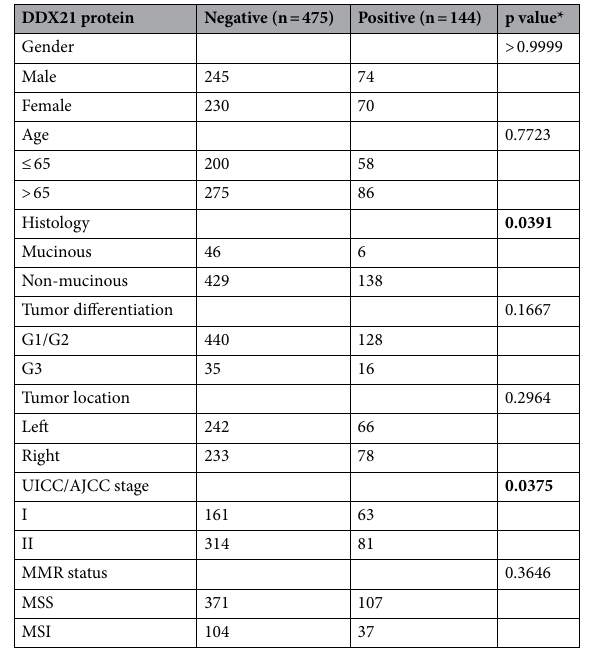
Table 1. DDX21 protein expression in the early stage colorectal cancer cohort (UICC/AJCC stages I and II combined). p values < 0.05 are indicated in bold MMR, mismatch repair. *Fisher’s exact test.